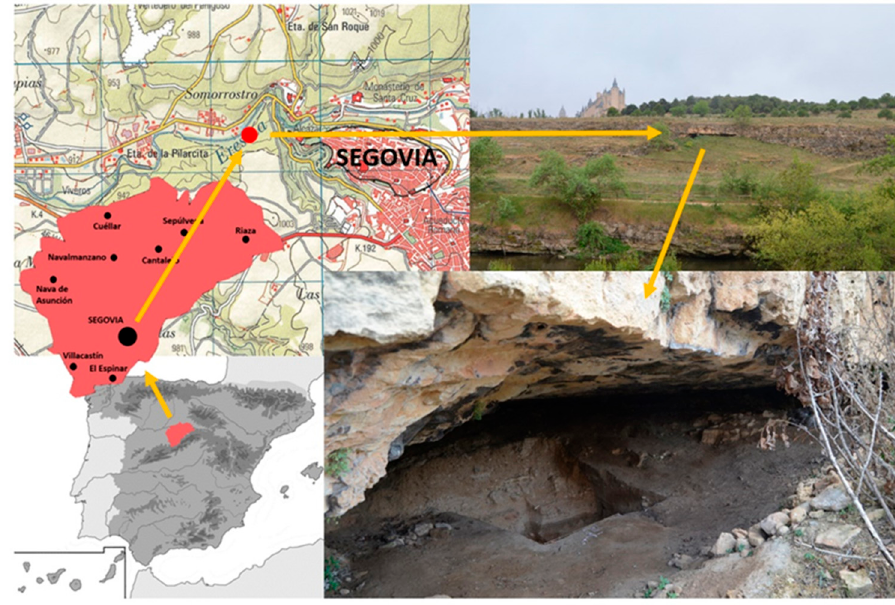
Figure 1. Location of the San Lázaro Rock Shelter (Segovia, Spain).